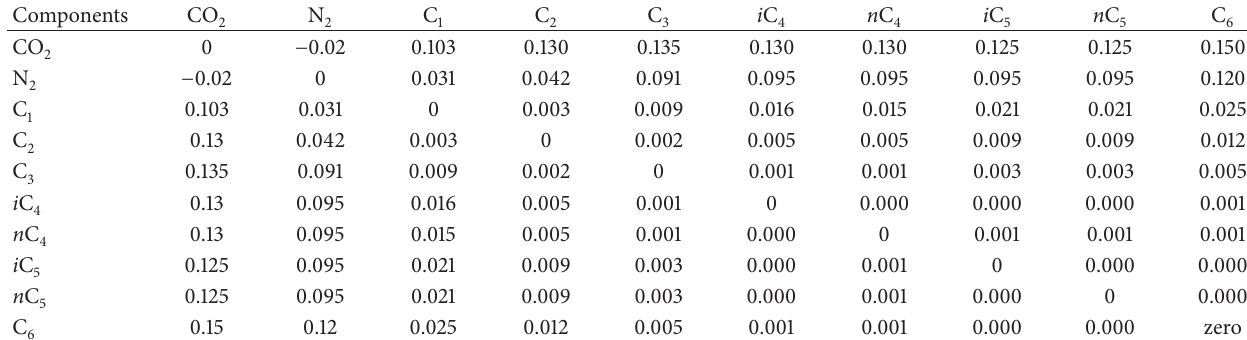
Table 6: Binary interaction parameters ( 𝑘 𝑖𝑗 ) and mixing rules for the model proposed in this study.